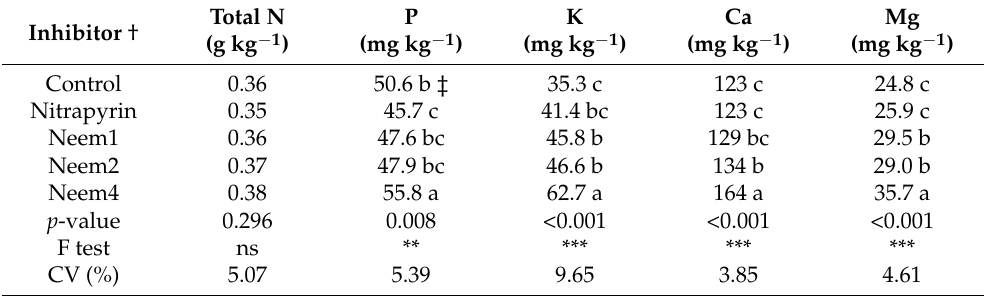
Table 3. Soil macronutrient concentrations at lettuce harvest as affected by different nitrification inhibitors.